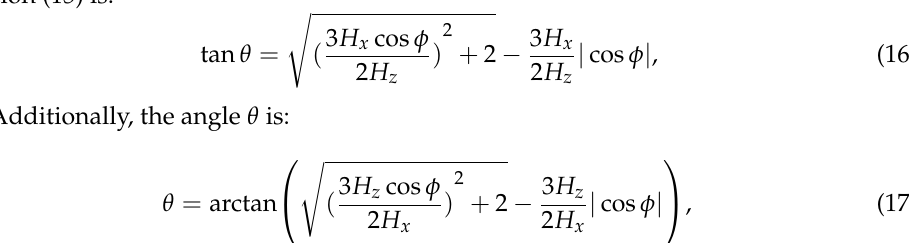
In AUV terminal guidance, the AUV navigates in front of the DS, so the range of θ is [ 0, π ] , which means the range of tan θ should be within [ 0, + ∞ ) . Thus, the solution tan θ in 2 Equation (15) is: